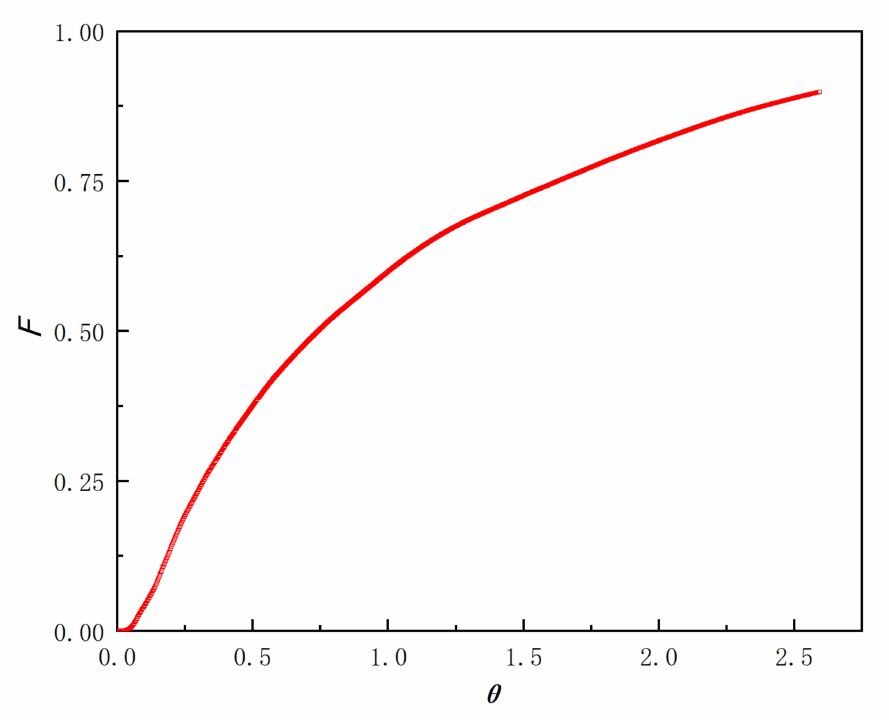
Figure 8. The characteristic F -curve of the experiment